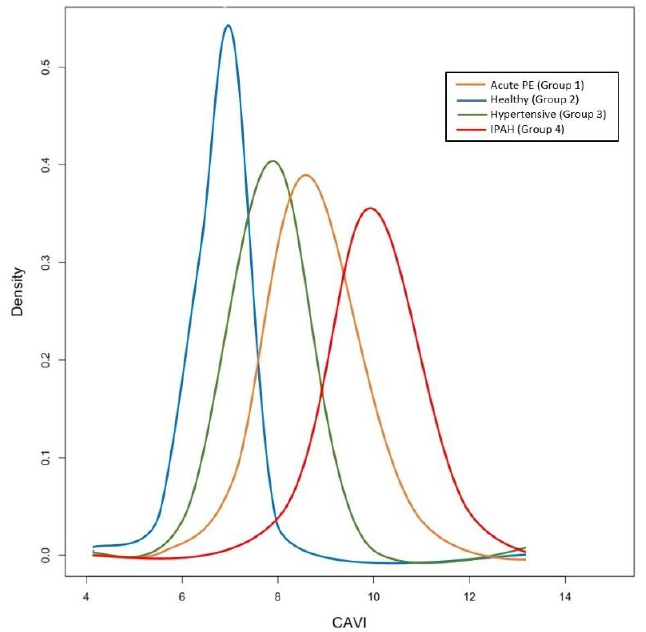
Figure 1 Distribution of the CAVI values for each cohort of patients. Group 1: patients with acute PE (orange line); Group 2: healthy subjects (blue line); Group 3: patients with systemic hypertension (green line); Group 4: patients with idiopathic pulmonary arterial hypertension (red line). CAVI was significantly increased in PAH and in acute pulmonary embolism patients compared with healthy subjects and systemic hypertension patients. Abbreviation: CAVI: cardio-ankle vascular index; PE: pulmonary embolism; IPAH: idiopathic pulmonary arterial hypertension.